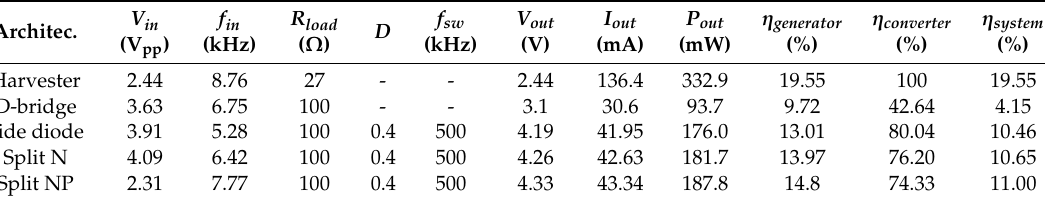
Table 24. Converters’ best results with the maximum input value: 10 m / s. Architec.